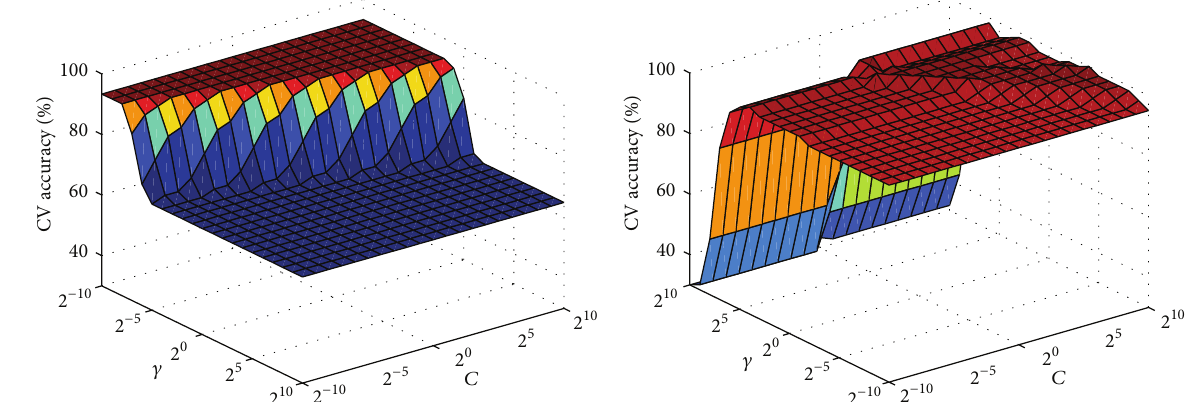
(b) RBF kernel function. Optimal 𝐶 and 𝛾 are 𝐶 = 2 −1 , 𝛾 = 2 3